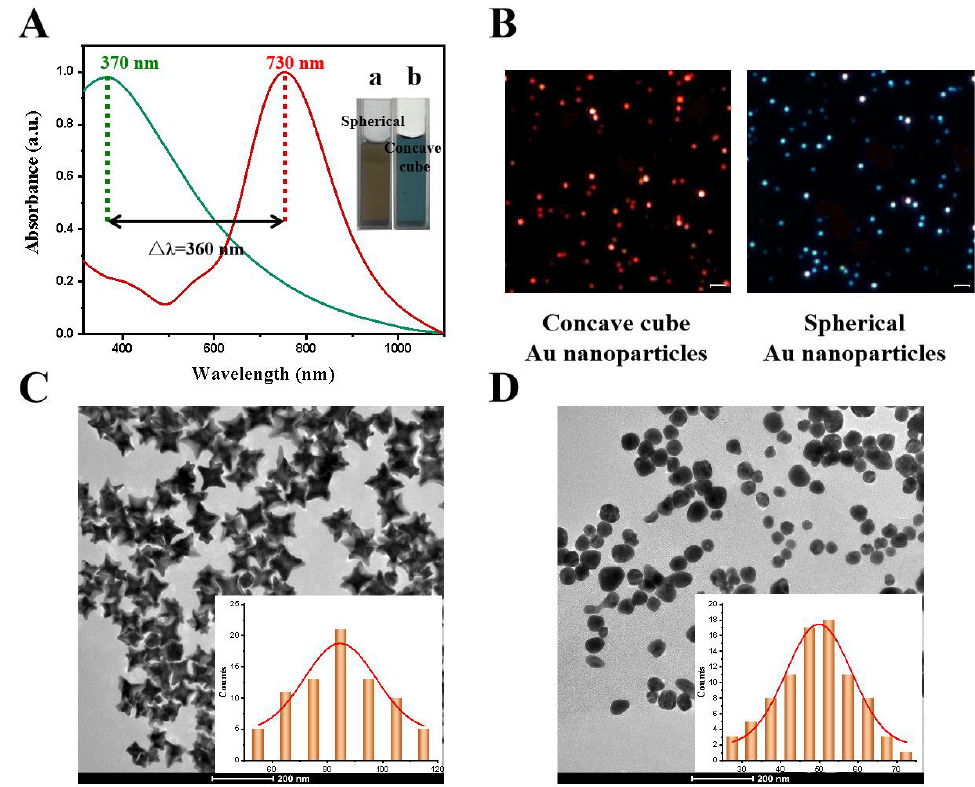
Figure 1. ( A ) UV-Vis spectra, ( B ) Representative DFM images, ( C ) TEM images of concave cubic Au nanoparticles, ( D )TEM images of concave cubic Au nanoparticles after incubation with 80 µ M AA and 200 µ M Hg 2+ (The inset is the corresponding nanoparticle size